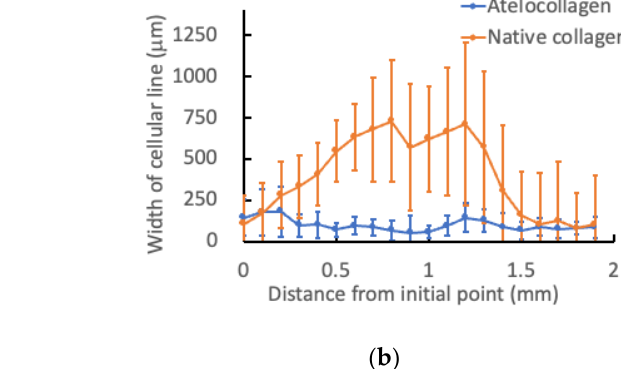
Figure 7. Width of cellular lines in collagen gels at ( a ) upper and ( b ) bottom lines. Mean ± S.D., n = 10.